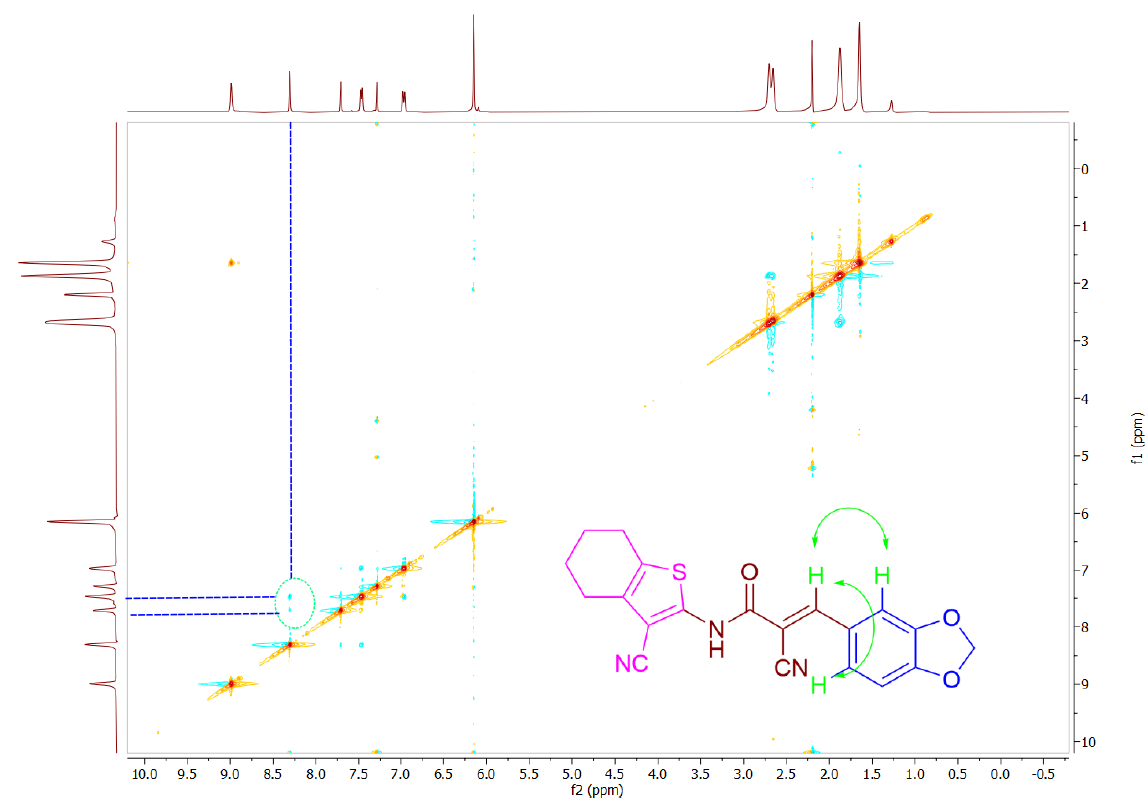
Figure 4. 2D NOESY NMR for compound 38b showing dipolar interactions at (8.30, 7.47 ppm) and (8.30, 7.71 ppm).